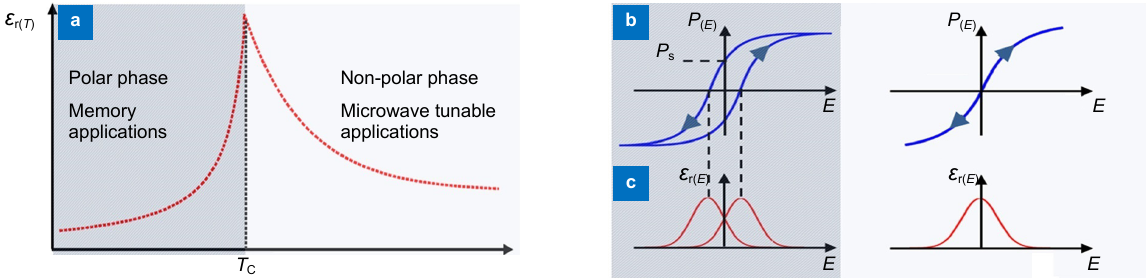
Fig. 6 | Phase transition in ferroelectric materials. ( a ) Temperature dependence of the dielectric constant of a ferroelectric material. The material transitions from a polar to a non-polar phase at the Curie temperature T c . ( b , c ) The corresponding polarization and dielectric constant as a function of applied field below and above T c . Figure reproduced from: ( a – c ) ref. 124 , AIP Publishing.